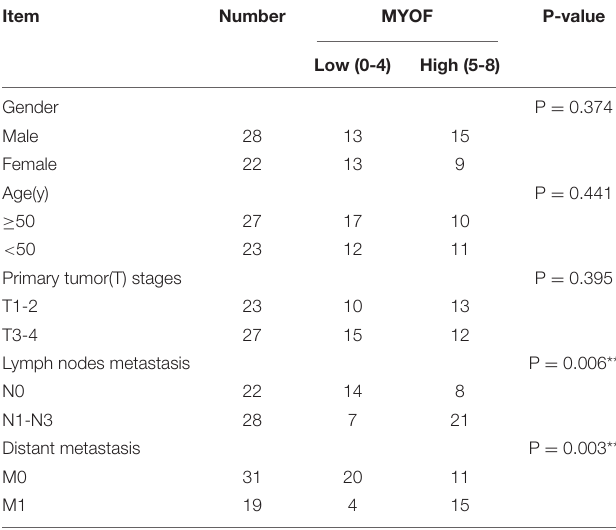
TABLE 4 | Association between MYOF expression and clinicopathological characteristics in 50 nasopharyngeal carcinoma